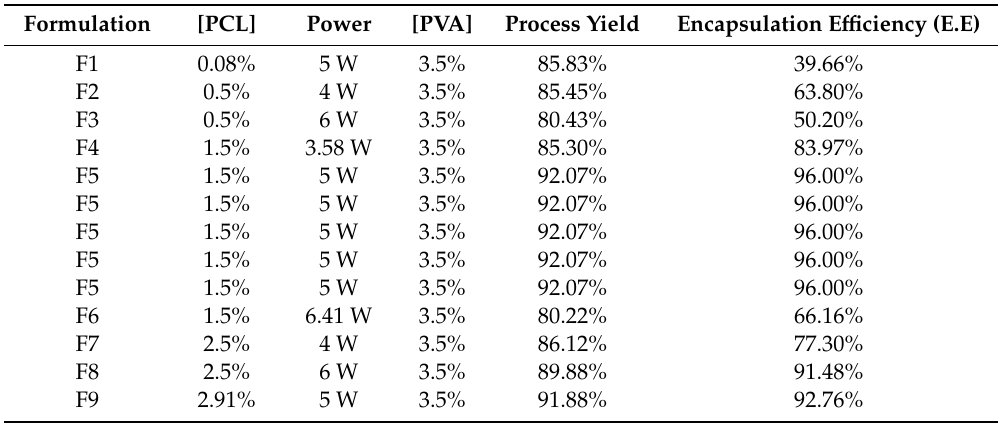
Table 1. Process parameters investigated in RSV-loaded microcapsules formulations (the inner and outer channel flow were both 3 mL / min), yield of the formulation process (%), and encapsulation e ffi ciency (E.E) for every RSV